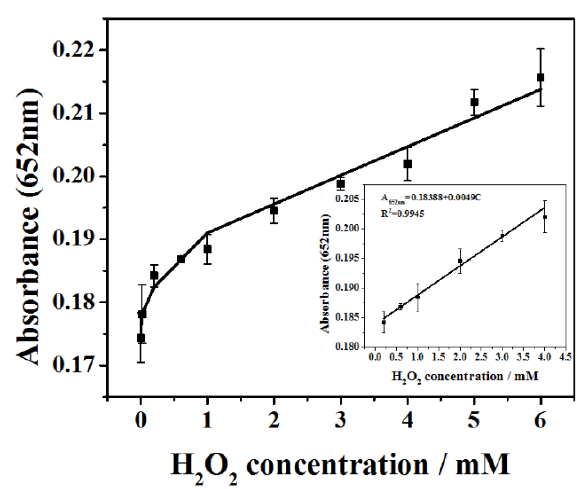
Figure 10. A concentration response curve H 2 O 2 detection. Inset: the linear calibration plot.